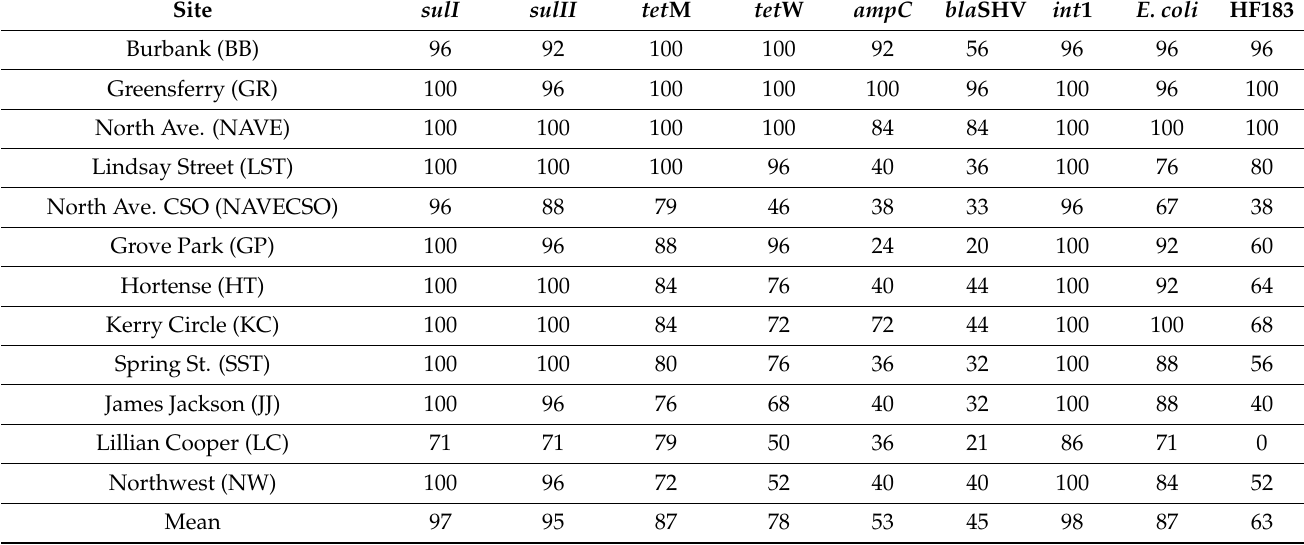
Table 1. Detection frequencies (%) of ARGs, class 1 integron, and fecal